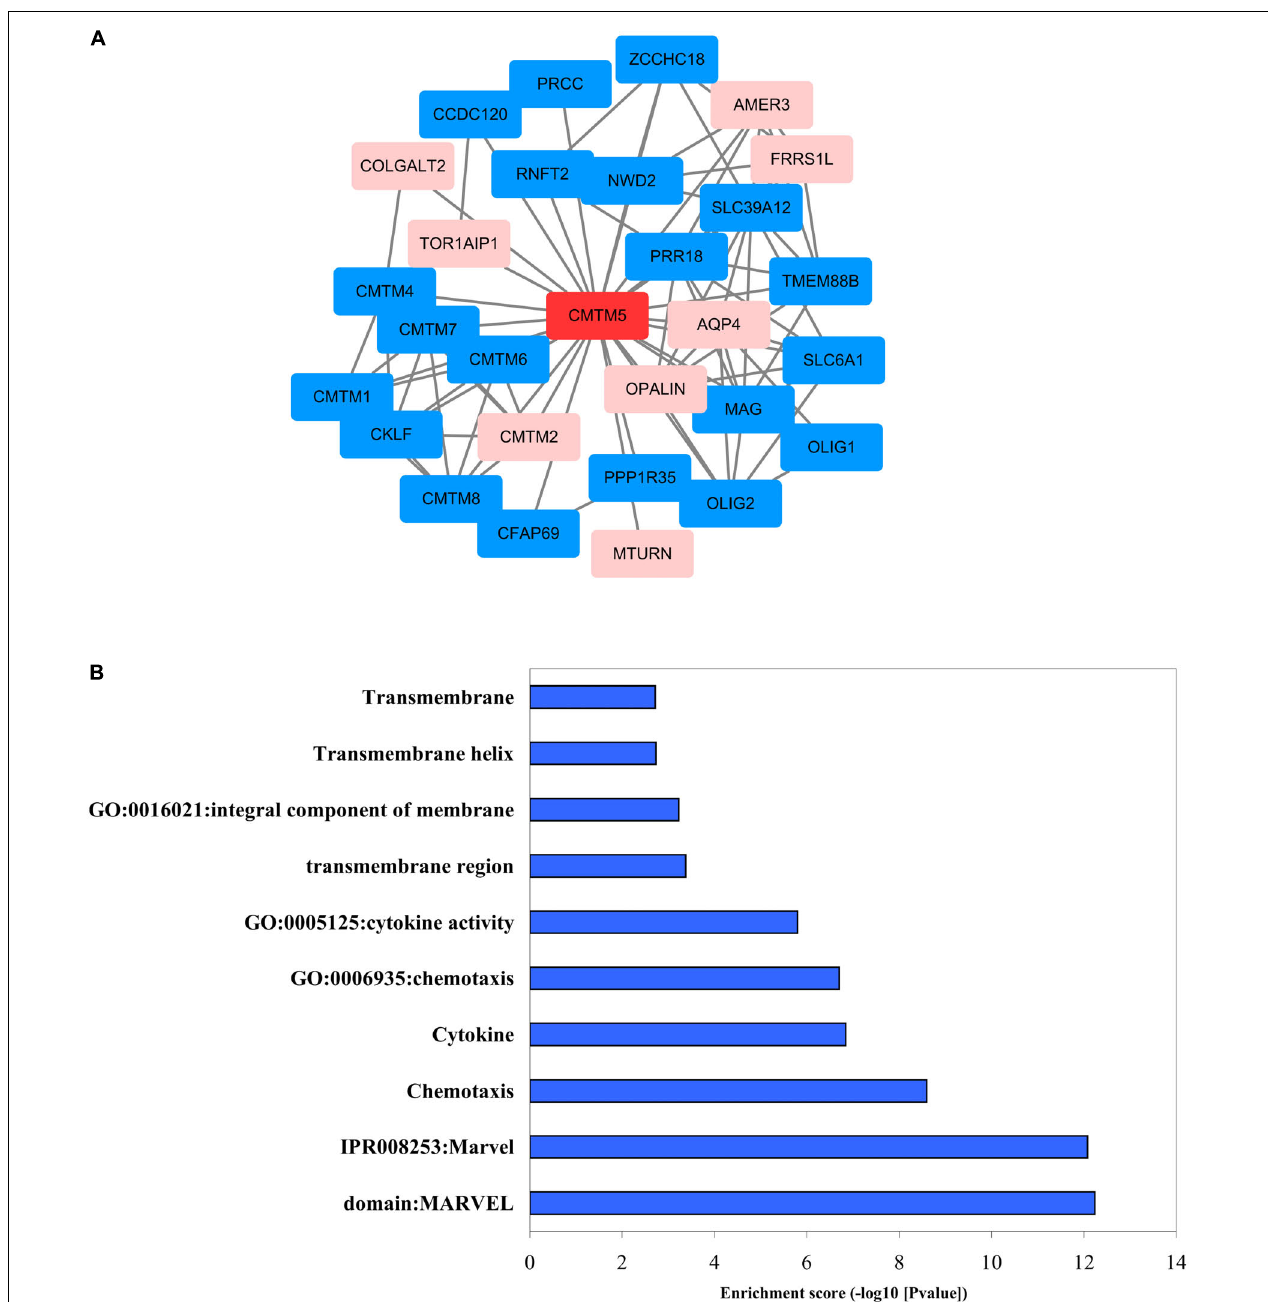
FIGURE 10 | Biomolecular regulatory network of CMTM5 . (A) Protein–protein interaction network complex and modular analysis using STRING (blue nodes indicate positive correlation and pink nodes show negative correlation). (B) Top 10 clusters identified via GO enrichment and KEGG pathway analysis using